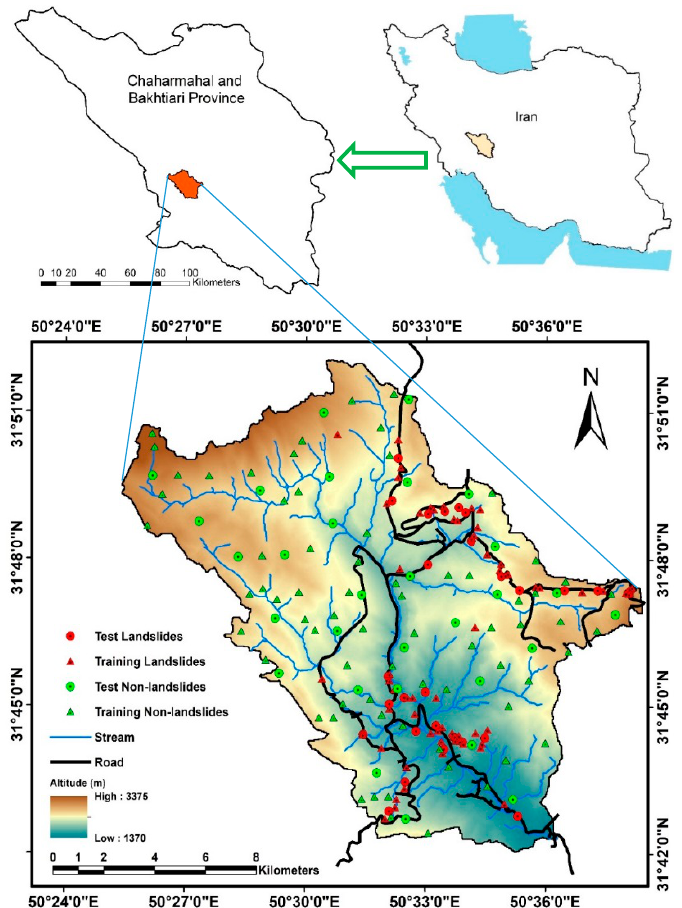
Figure 1. Location of the study area in Iran; the red circles denote landslides for testing; the red triangles denote landslides for training; the green circles denote non-landslides for testing; and the green triangles denote non-landslides for training.